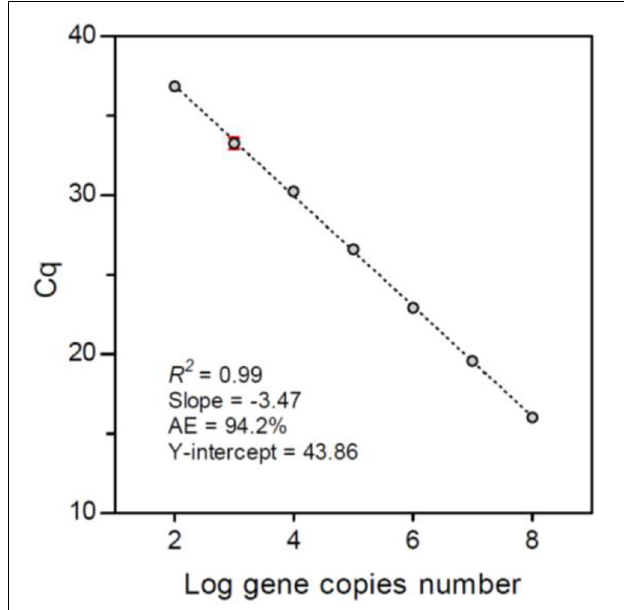
FIGURE 5 | Calibration curve of the cycle threshold (Cq) constructed using the synthetic gene fragment of Alexandrium tamiyavanichii ITS2 rDNA. Error bars show the standard deviations from the triplicate